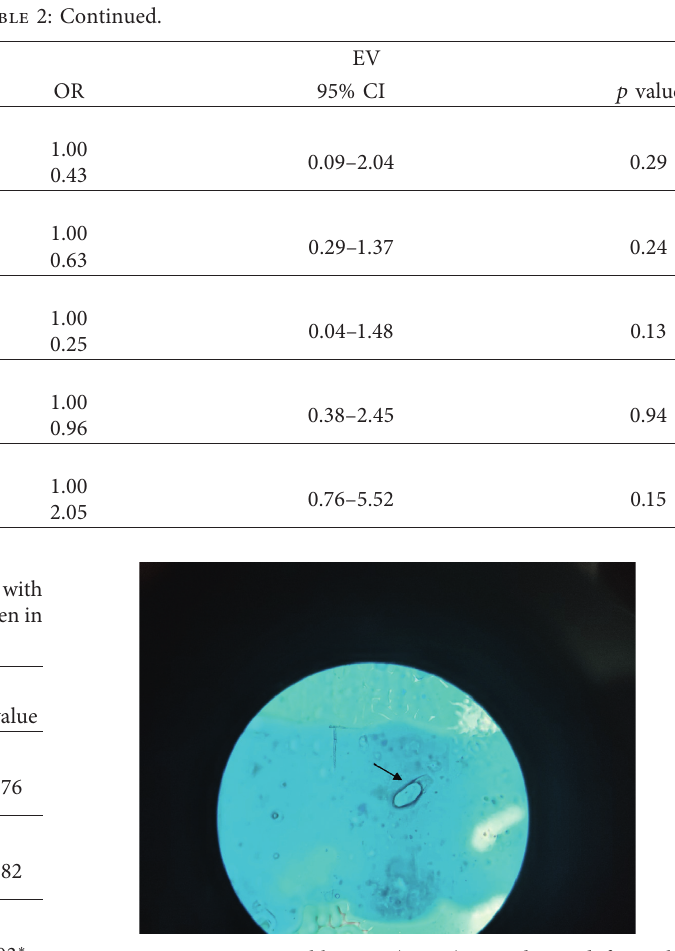
Figure 1: A pinworm-like egg (arrow) was detected from the thumb of a